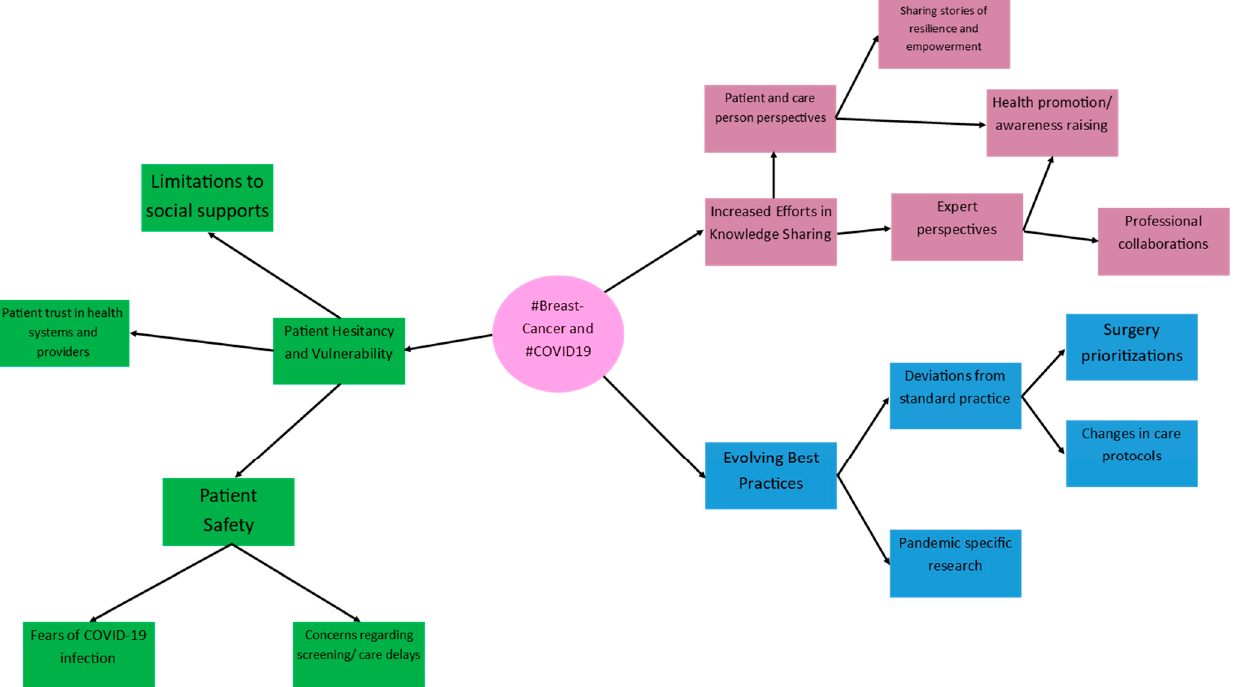
Figure 3. Thematic map outlining major themes and sub-themes extracted from tweets.